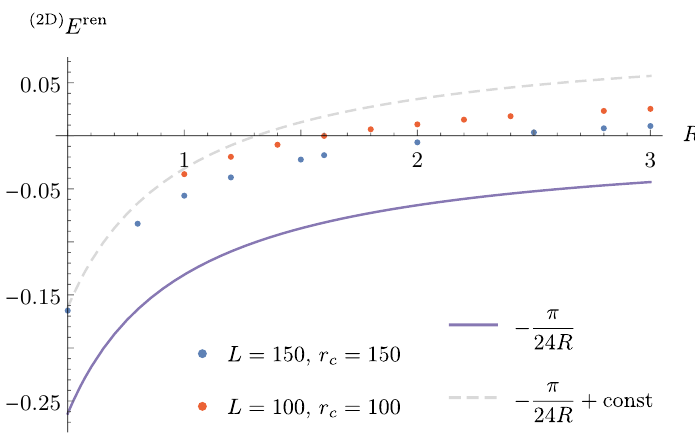
Figure 4 . Casimir energy, calculated numerically (data points) for a = 0 . 1 and two different sets of parameters r c and L . Compared to the standard result due to Dirichlet boundary conditions (purple solid curve) and the shifted version (gray dashed